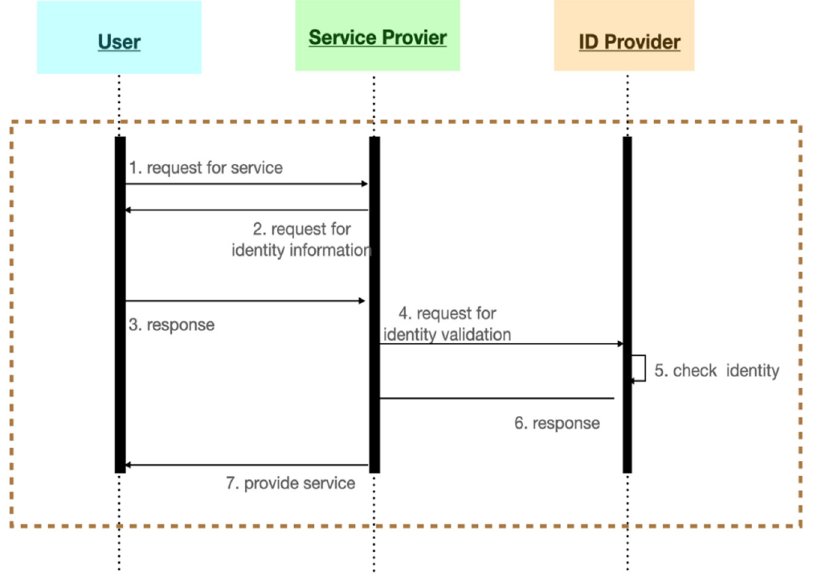
Figure 1. Traditional identity management architecture.